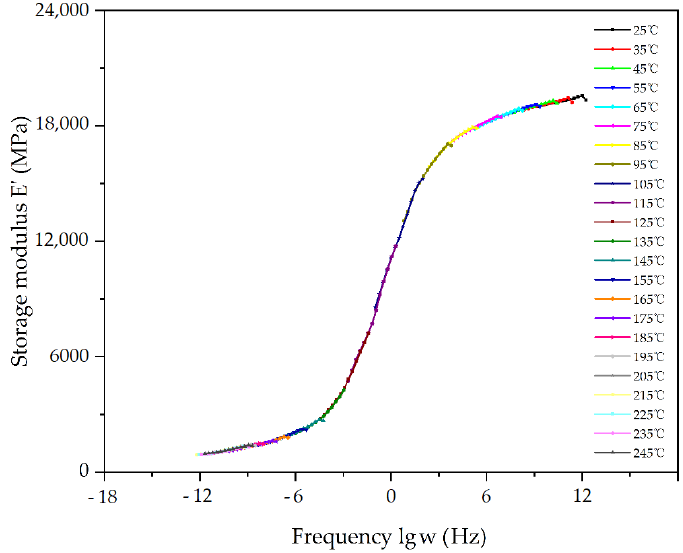
Table 3. Viscoelastic material parameters of epoxy molding compound.